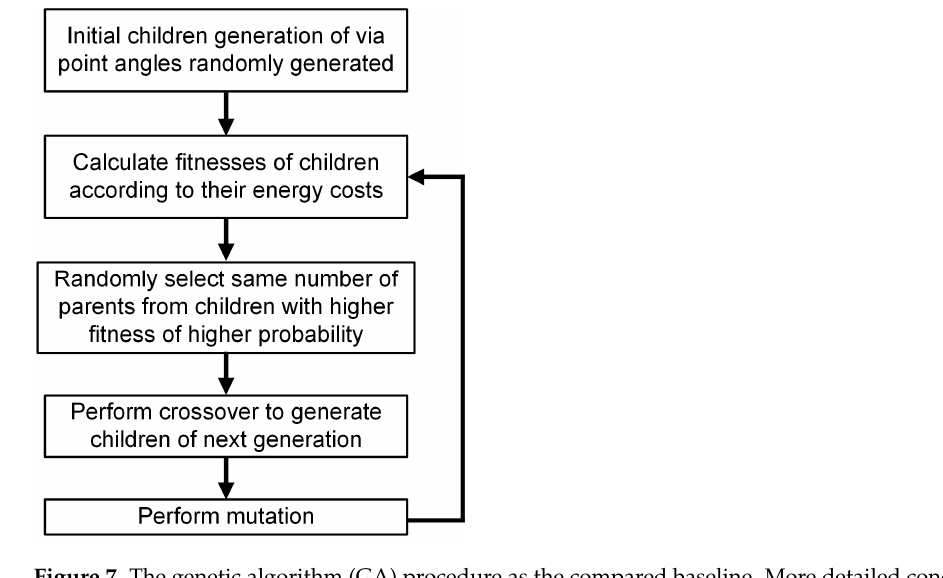
Figure 7. The genetic algorithm (GA) procedure as the compared baseline. More detailed concepts of GA can refer to [48] .